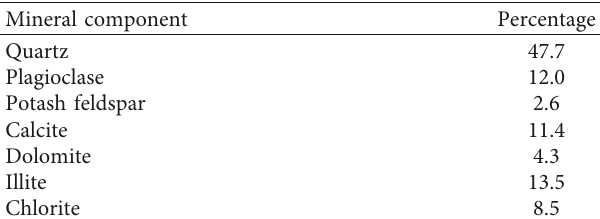
Table 2: Mineral component of tested